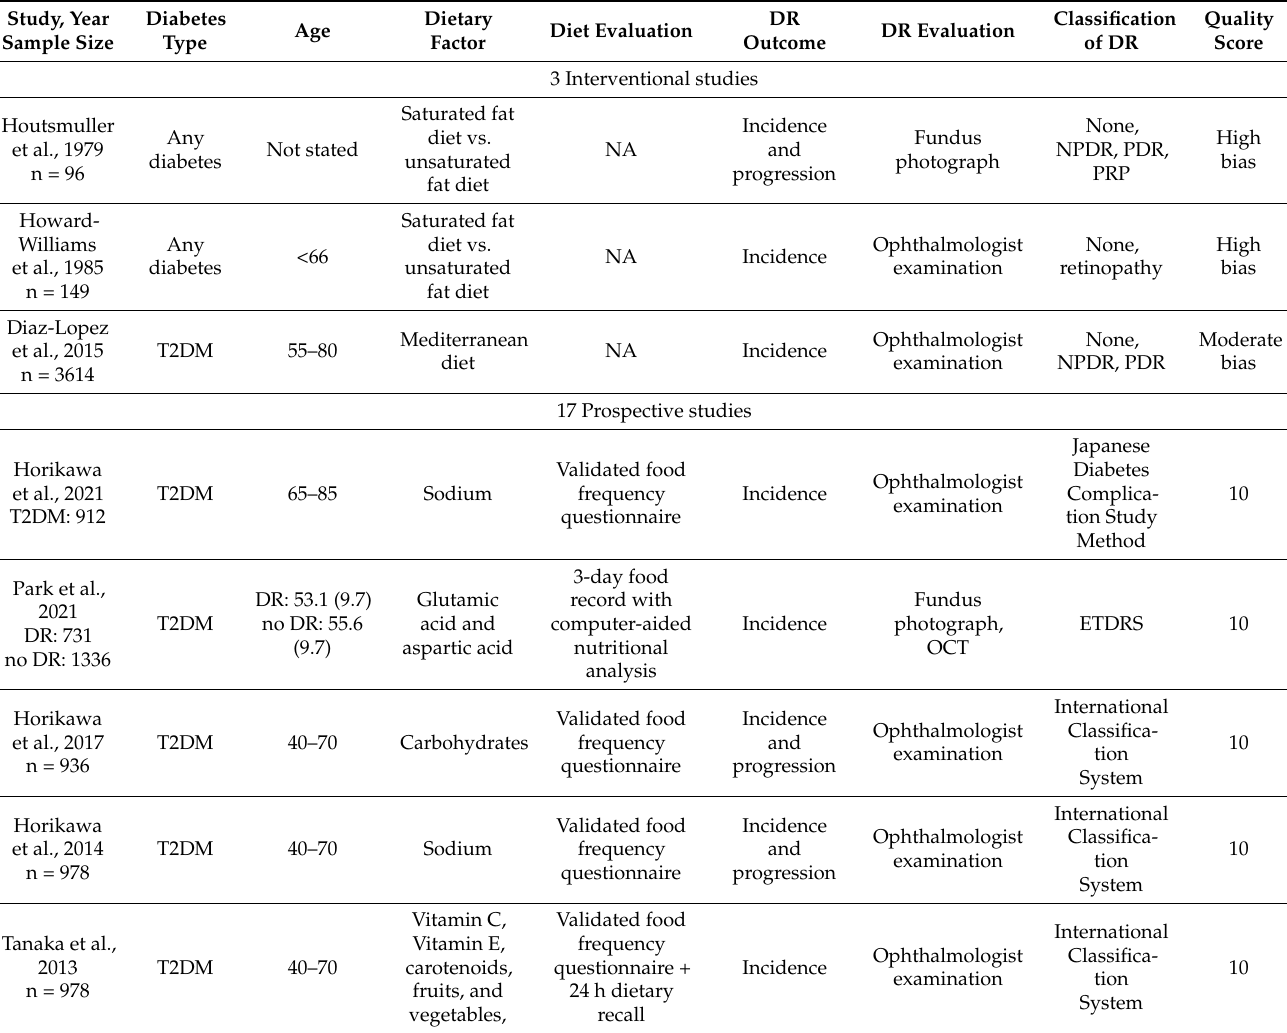
Table 1. Characteristics of studies (n =